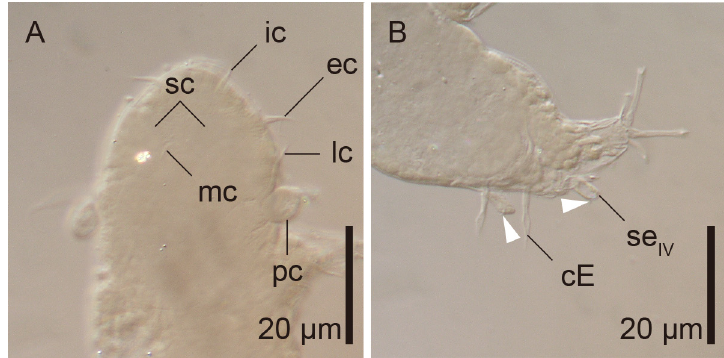
Fig. 4. Micrographs of Angursa lanceolata Renaud-Mornant, 1981 paratype. A . Cephalic region. B . Caudal region with leg IV sensory organ terminating in short, apical spine (white